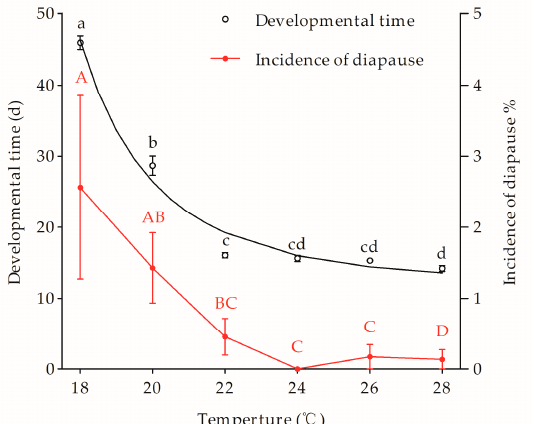
Figure 4. Thermal effects on larval development (days) and diapause incidence (%) in the Lm strain under a 16-h daylength. Symbols and bars represent the mean ± SE values. Different uppercase and lowercase letters indicate significant differences ( p < 0.05) among diapause incidence in Ln strain and developmental time of Lm strain.